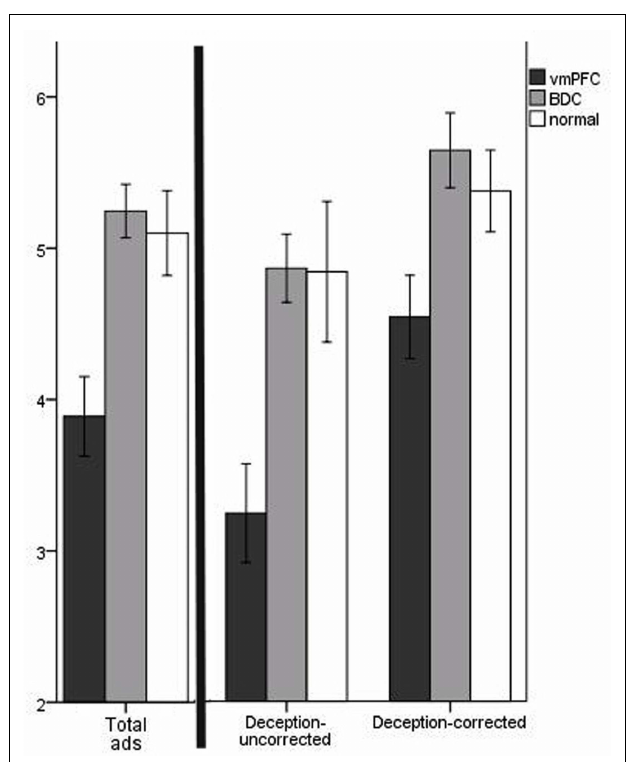
FIGURE 3 | Mean belief scores for misleading ads. The scale is from 1 to 7 ( y -axis), with lower values corresponding to increased belief in misleading aspects of the ads and higher values corresponding to increased skepticism for misleading aspects of the ads. Error bars indicate SEM.The graph on the left of the black bar represents results for all six misleading ads; the graph on the right of the black bar breaks the results down according to “deception-uncorrected” and “deception-corrected” ads. For all the ads, vmPFC patients had more credulity than BDC patients and normal comparison